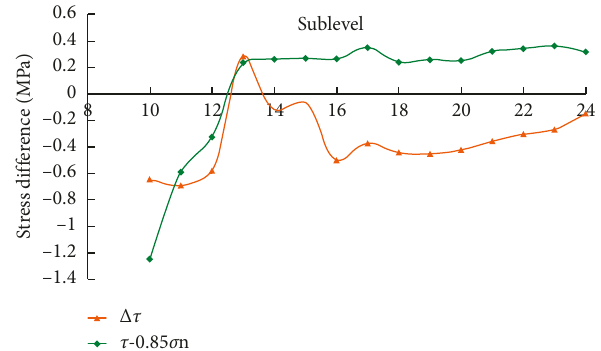
Figure 8: The slip property of fault F2 varies with mining depth.